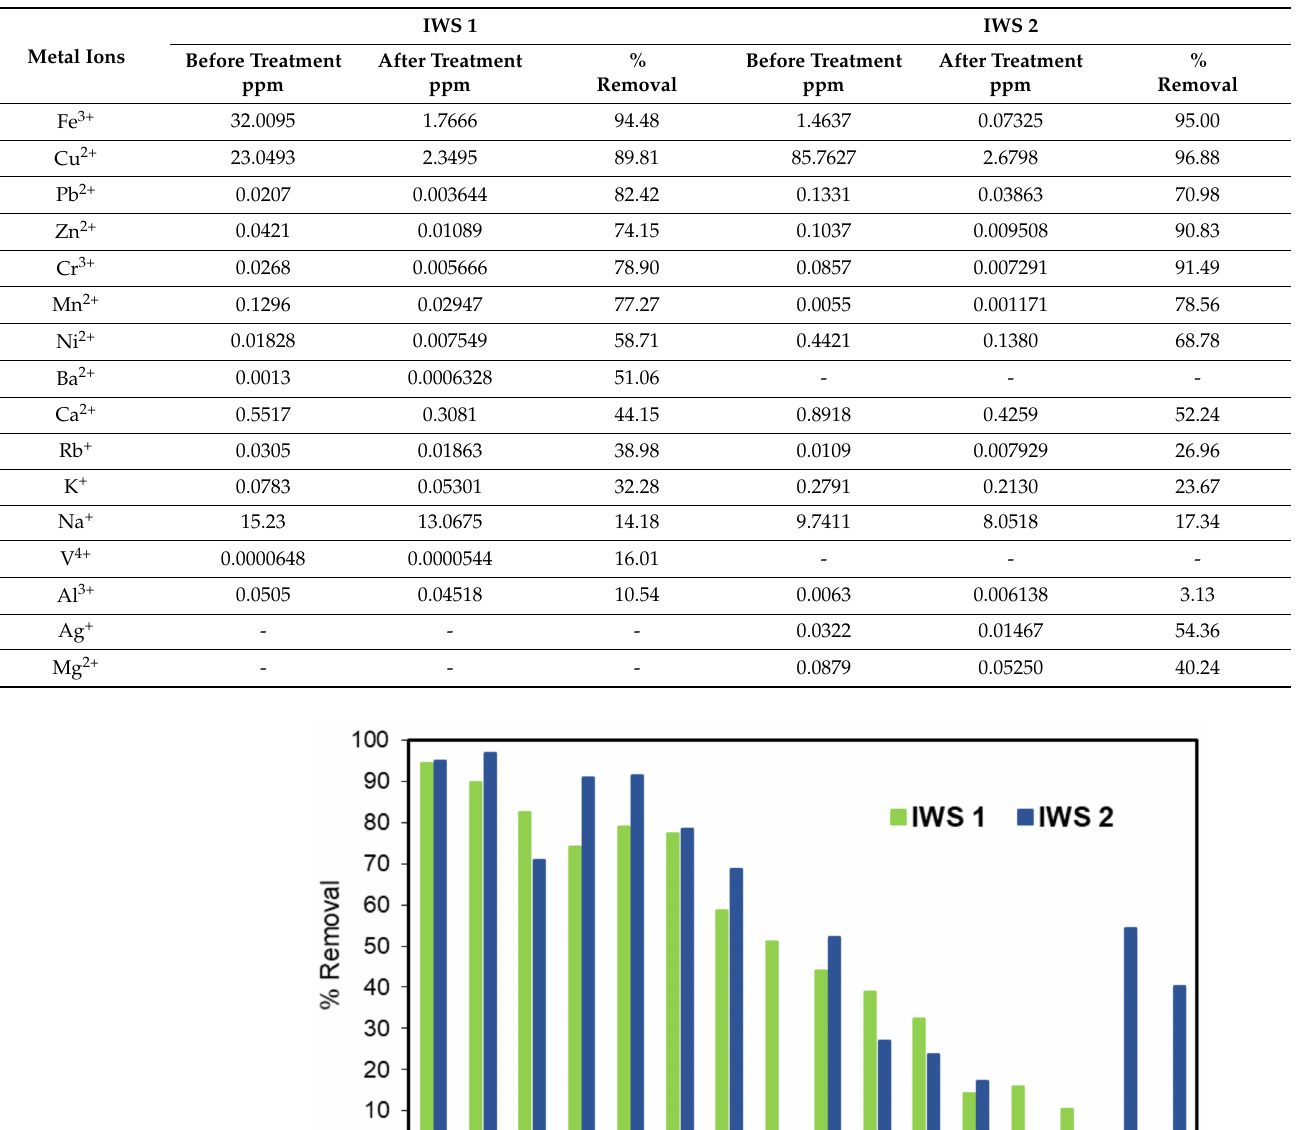
Table 6. Compositions of metal ions in the industrial wastewater samples (IWS 1 and IWS 2) before and after treatment by poly(amidoxime) ligand.